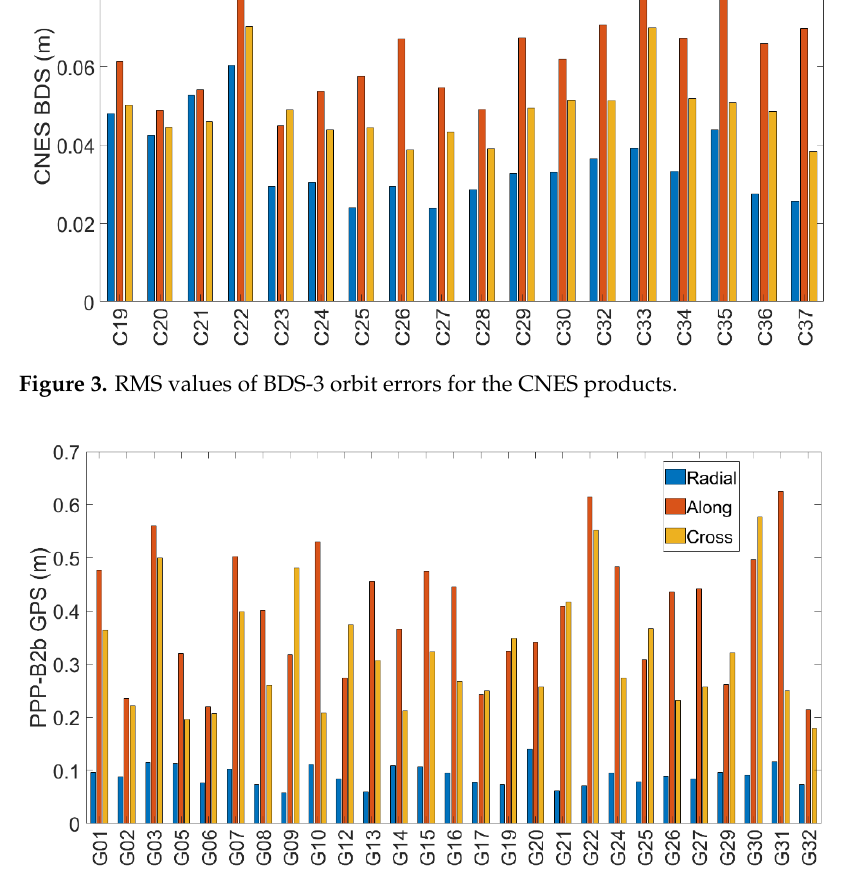
Figure 4. RMS values of GPS orbit errors for the PPP-B2b products.